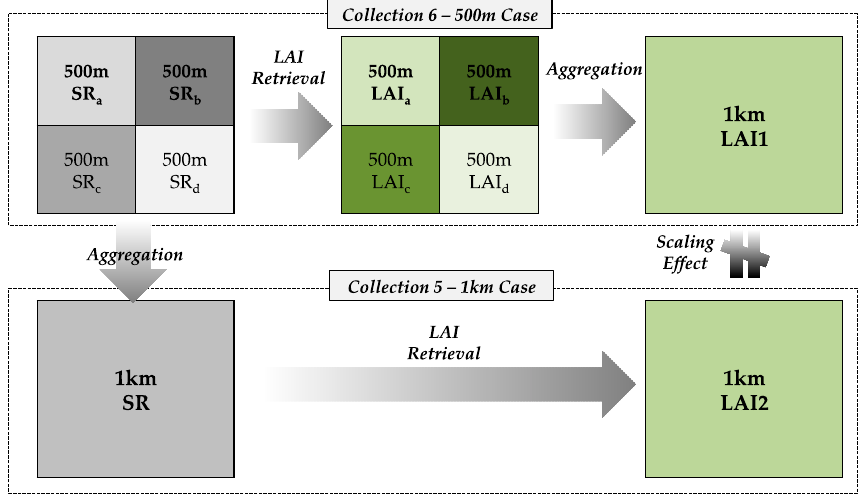
Figure 9. Theoretical description of scale effect.